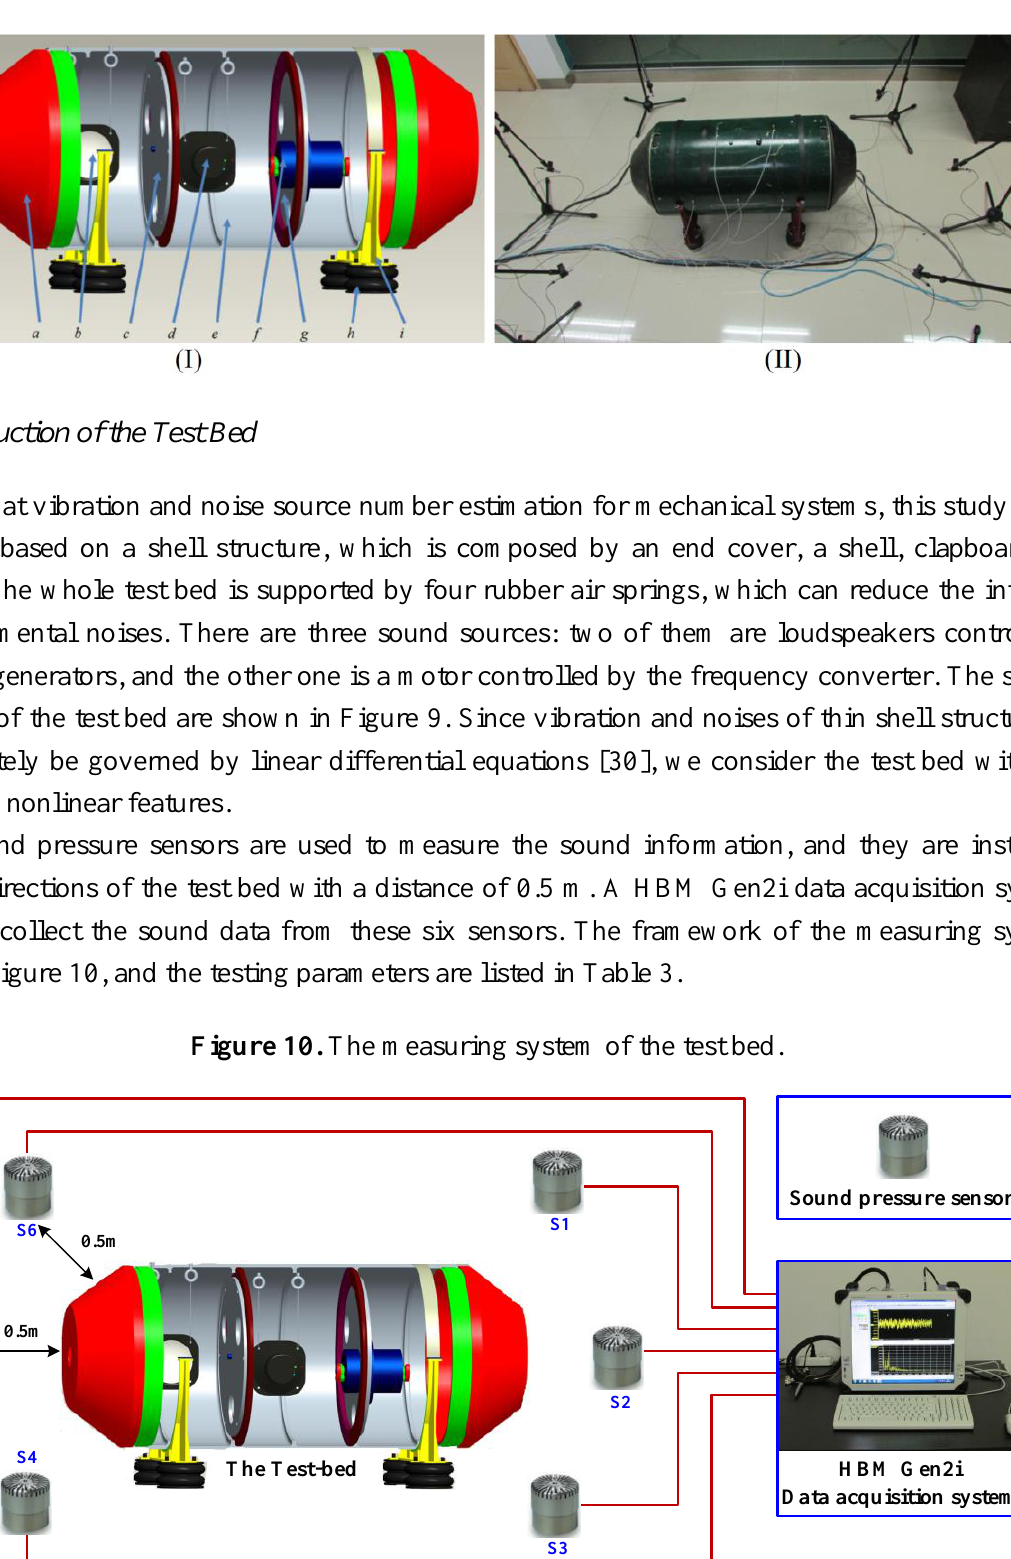
Figure 9. The structure (I) and photo (II) of the test-bed: ( a ) End cover. ( b ) Loudspeaker I. ( c ) Left clapboard. ( d ) Loudspeaker II. ( e ) Shell. ( f ) Motor. ( g ) Right clapboard. ( h ) Rubber springs. ( i ) Supports.